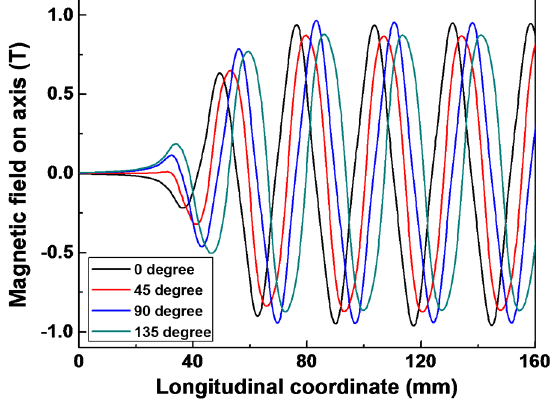
FIG. 6. Measured transverse component of field on the un- dulator axis at the period length of 26 mm. Four curves correspond to different orientations of the Hall probe: red — vertical, green — 45° clockwise, blue — 90° clockwise (i.e., hori- zontal), black — 135° clockwise. The third harmonics of the undulator field decreases field maxima at skewed axes and increases them at normal (vertical and horizontal) ones (first and third harmonics rotate in opposite